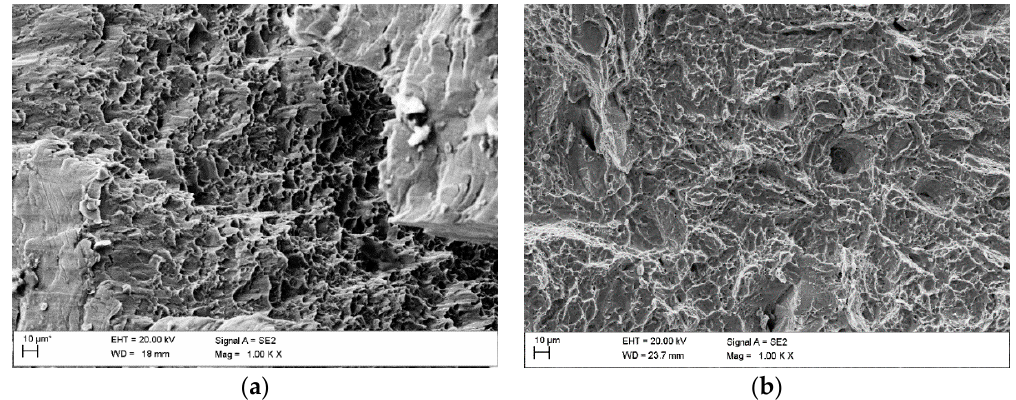
Figure 12. Comparison of fracture morphology after static bending tests. ( a ) Ti6Al4V casting alloy after milling in a CNC milling centre. ( b ) Sintered alloy using the SLS method (Ti solid 4 variant) (SEM).